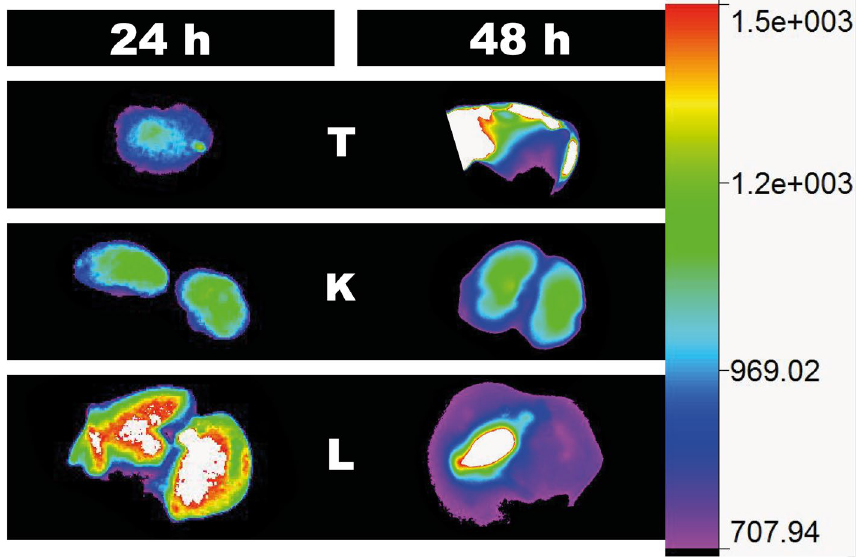
Figure 8. Ex vivo images with Sgc8-c-Alexa647 probe. Tumor (T), kidneys (K) and liver (L) were observed for melanoma tumor model generated with B16F10 cells 24 and 48 h post-injection of the probe.